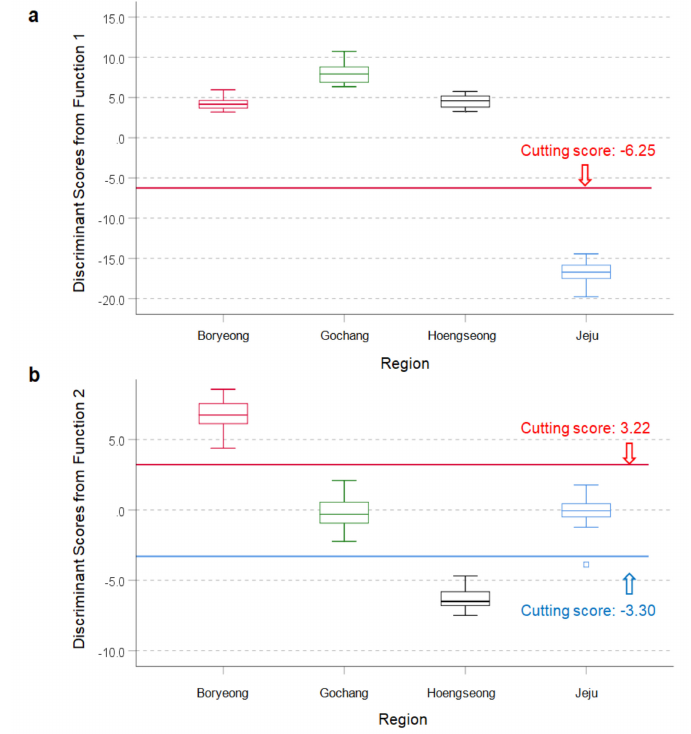
Figure 4. Box-and-whisker plots for discriminant scores from the function 1 ( a ) and the function 2 ( b ) of the discriminative model (see Figure 3a) developed for organic milk (OM) regional authenticity (see Figure 1. about the description for box-and –whisker